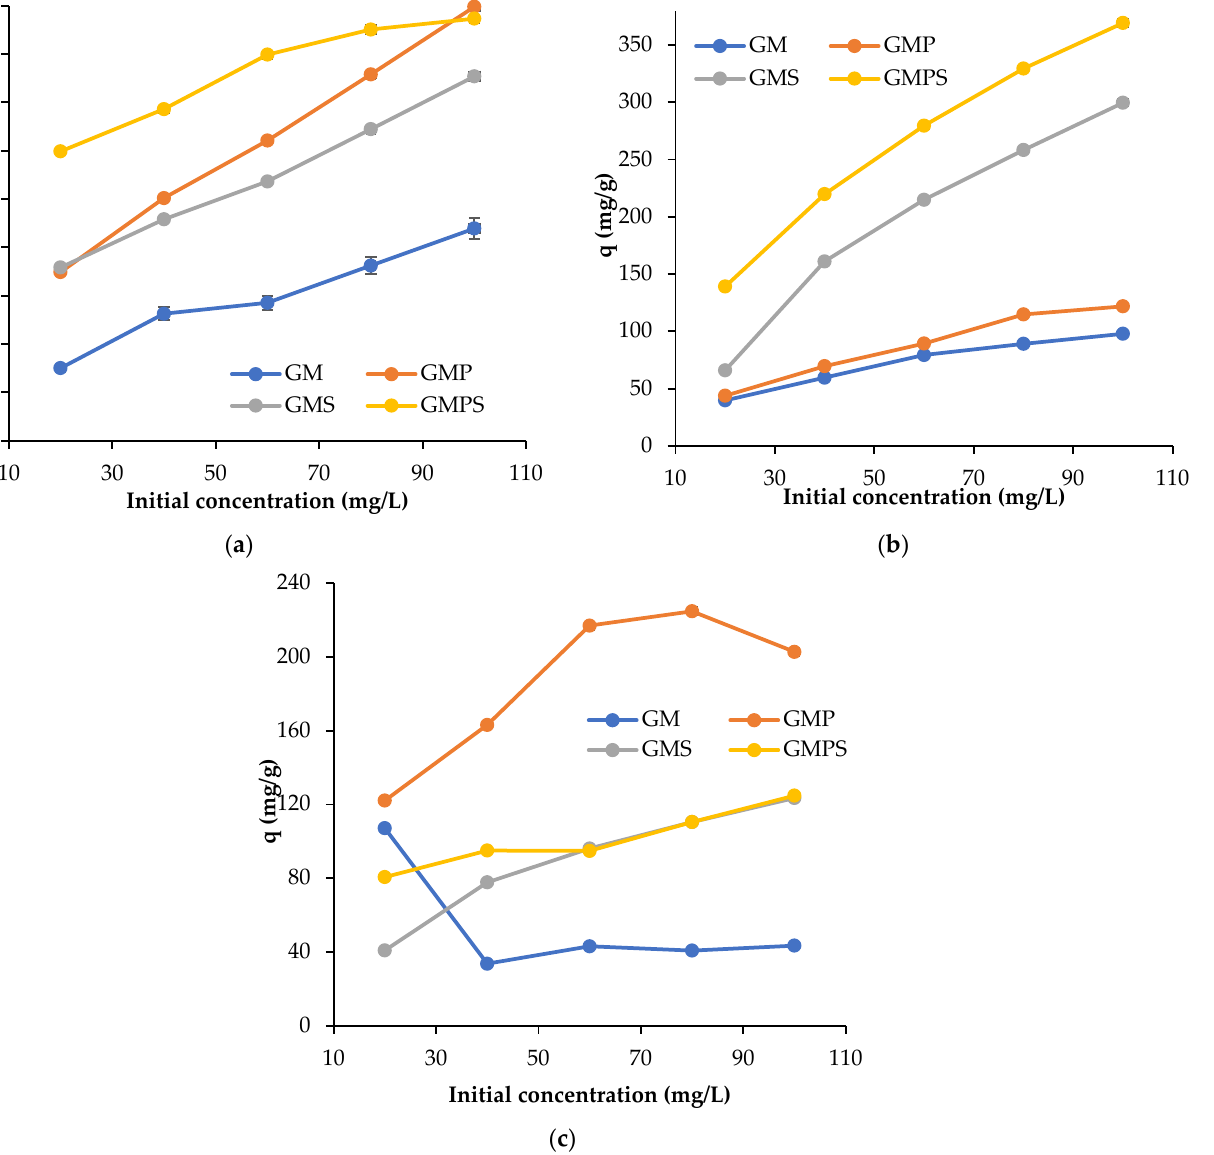
Figure 1. Effect of initial dye concentration on adsorption capacity of golden marble stone powder ( a ) Foron black dye, ( b ) Foron blue dye, and ( c ) Foron red dye.